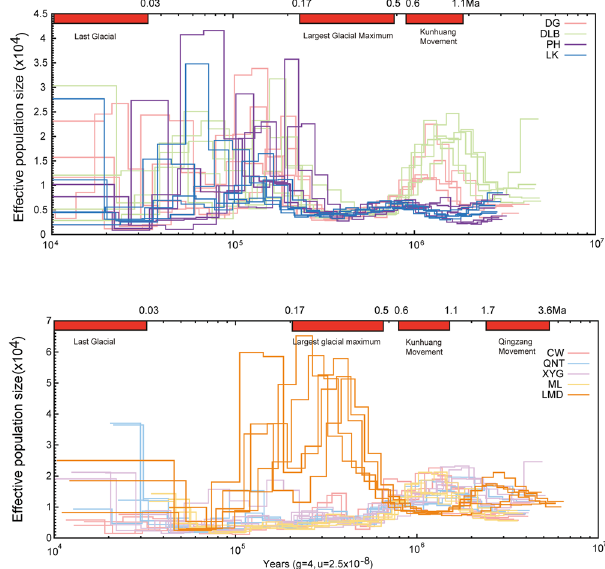
Figure 5. Inference of ten C. macropterus populations demographic history. each thin line represents one individual, each population is represented by five individuals. The above is the effective population size of populations in MS, and the below is the effective population size of populations in all